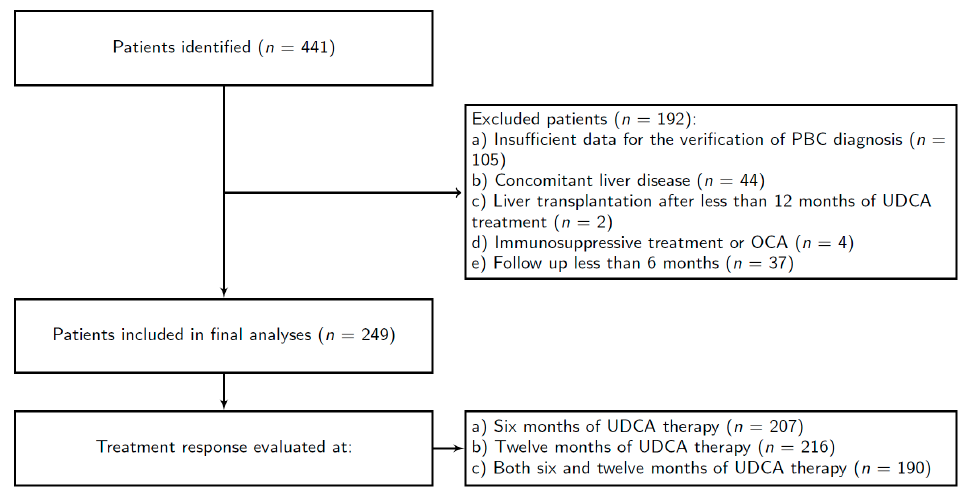
Figure 1. Flowchart of patients’ inclusion.